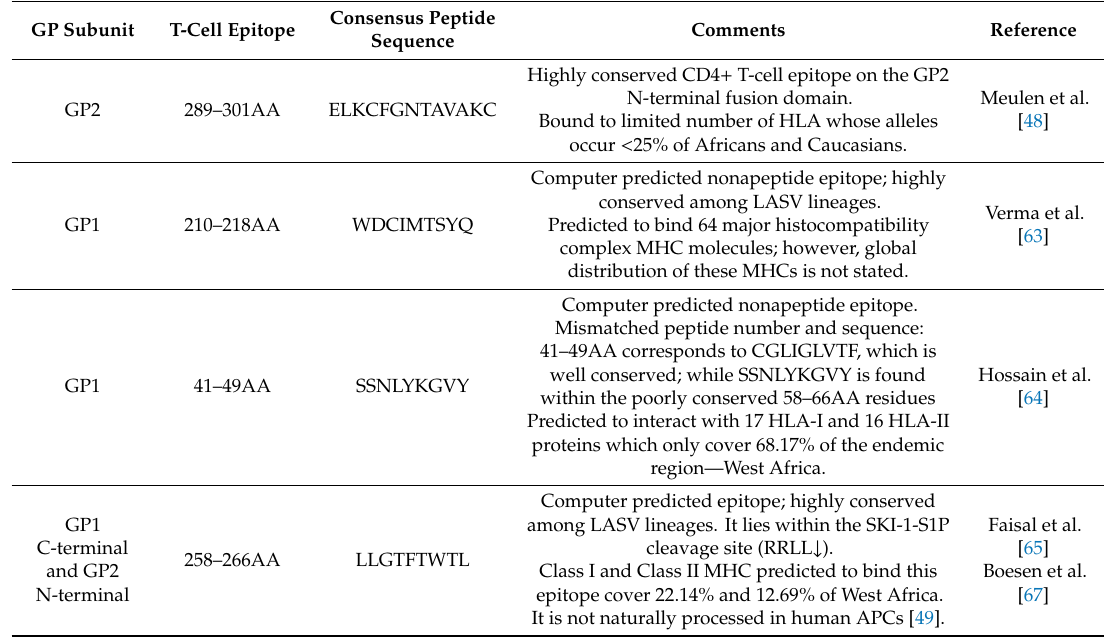
Table 3. Other LASV-specific T-cell